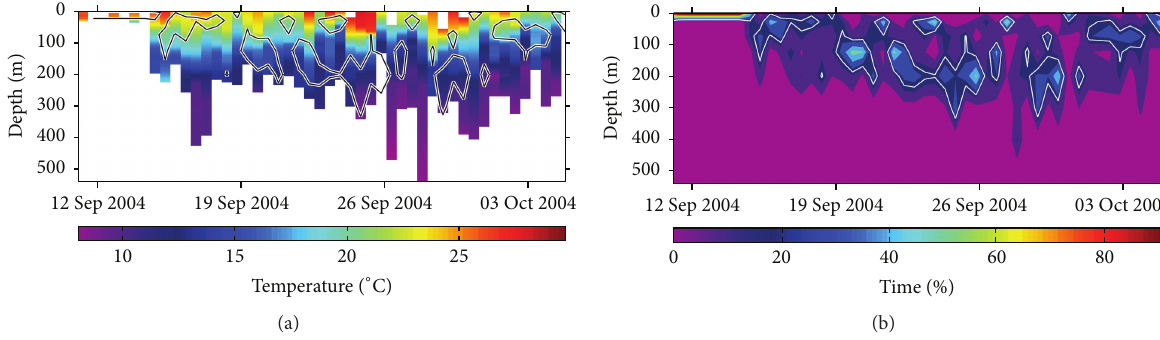
Figure 6: Depth occupation in relation to water column thermal structure for 2004 data from Fish A, tag 52918. (a) Thermal cross section of water column traversed by fish; each vertical bar represents a 12hr time period, extending to the deepest point reached during the period and color-coded by temperature. Black contours define corresponding time at depth (TAD) > 25%. (b) Corresponding TAD